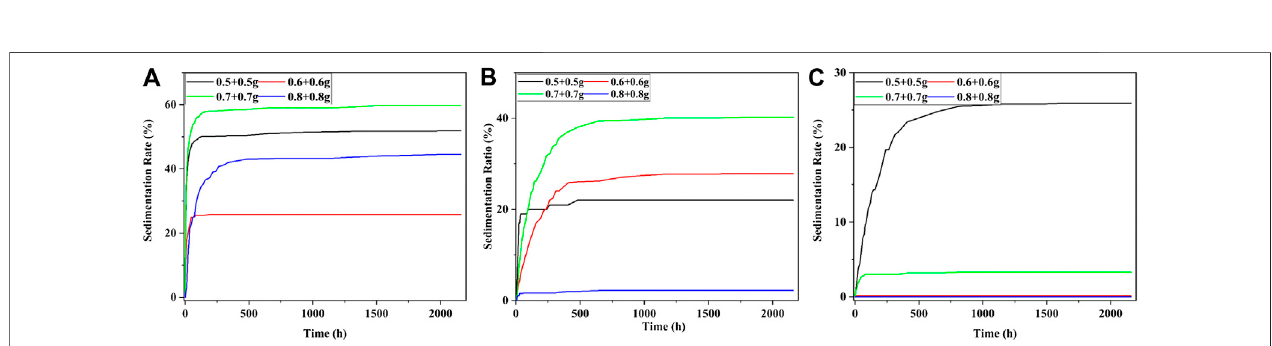
Frontiers in Materials |